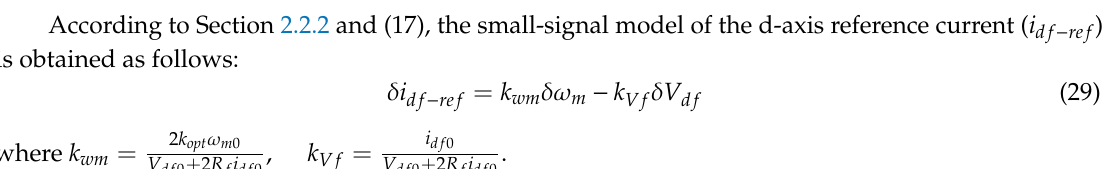
Figure 8. Small signal block diagram of dc-link voltage and q-axis current controller.